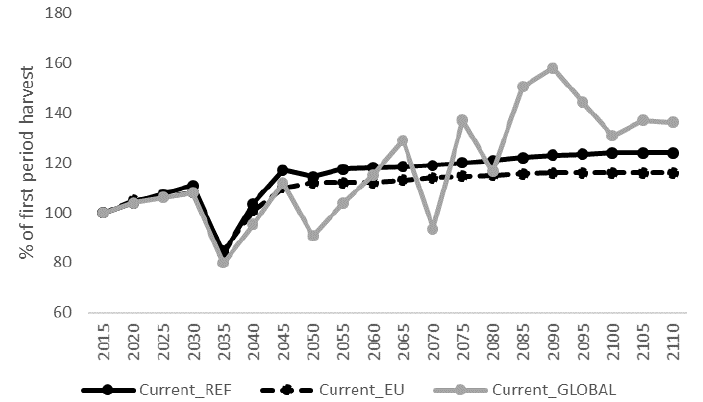
Figure 4. Projected harvests (expressed as percentage of first period harvest) of roundwood (sawlogs and pulpwood from thinning and final felling) with current forest management practices in the three climate change mitigation scenarios.